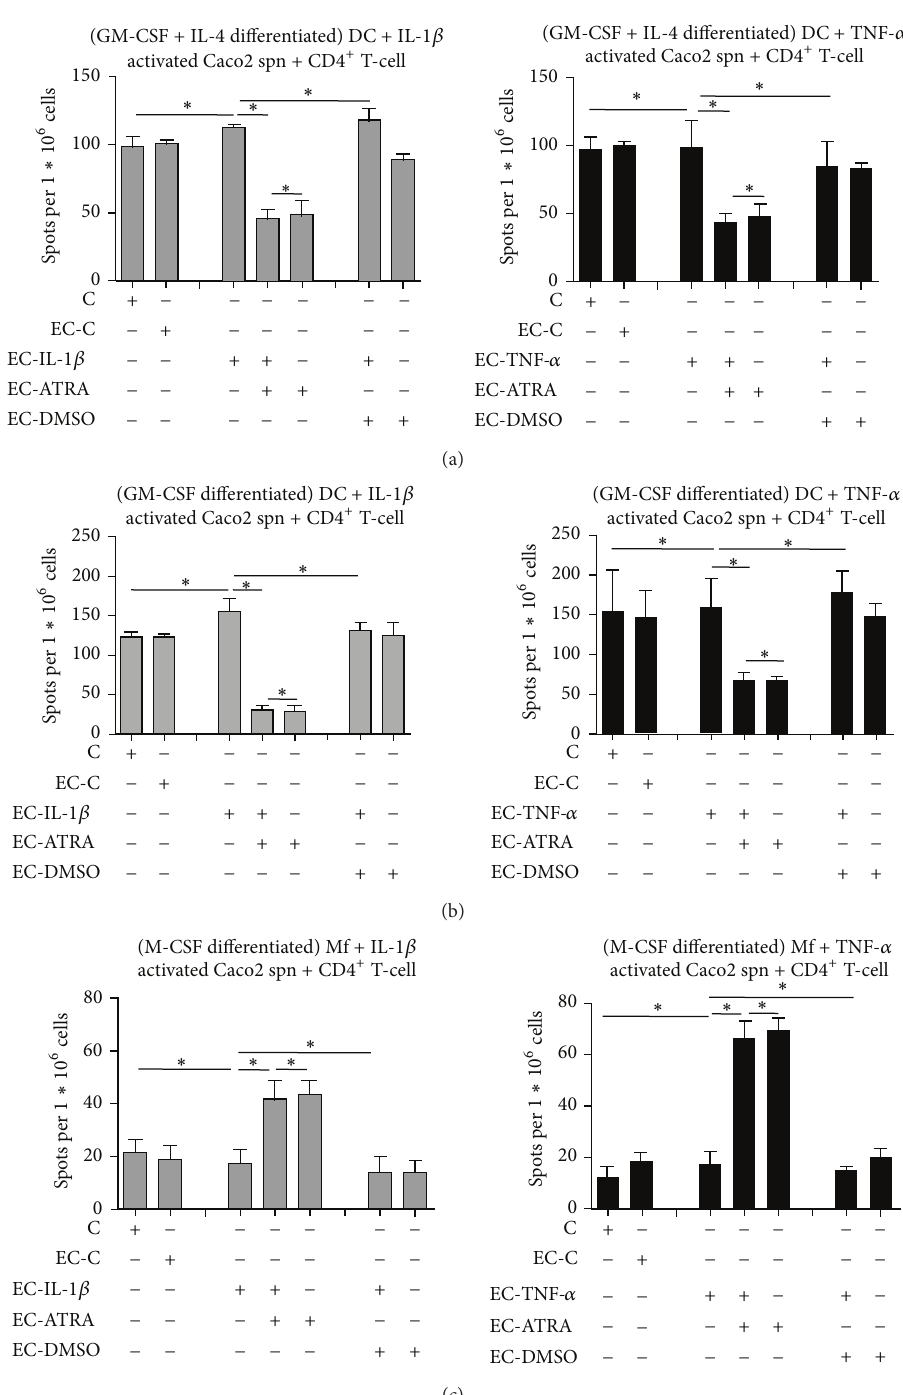
Figure 5: The effect of gut epithelial cell-mediated myeloid cell stimulation on the activation and polarization of T-lymphocytes. To assess the effects of stimulated myeloid cells on effector T-cell polarization, the supernatants of activated Caco2 cells were added to myeloid cells differentiated by GM-CSF+IL-4, GM-CSF, or M-CSF for 3 days and the washed cells were cocultured in fresh medium with autologous CD4 + T-lymphocytes for another 2 days. The activation and polarization of CD4 + T-cells c-incubated with myeloid cells generated by GM-CSF+IL- 4 (a), GM-CSF (b), or M-CSF (c) was detected by the IL-17 ELISPOT assay. In the figure legends, C stands for unstimulated myeloid cells coincubated with CD4 + T cells, EC-C for monocyte-derived cells “educated” by resting Caco2 cell supernatant followed by coincubation with CD4 + T cells, and EC-IL-1 𝛽 , EC-TNF- 𝛼 , EC-ATRA, and EC-DMSO correspond to cultures containing monocyte-derived cells “educated” with the supernatants of Caco2 cells pretreated with IL-1 𝛽 or TNF- 𝛼 in the presence or absence of ATRA, or with DMSO used as solvent control, followed by coincubation with CD4 + T cells. ∗ 𝑃 < 0.05 . Mean ± SD of the number of IL-17 secreting cells measured in 4 independent experiments is